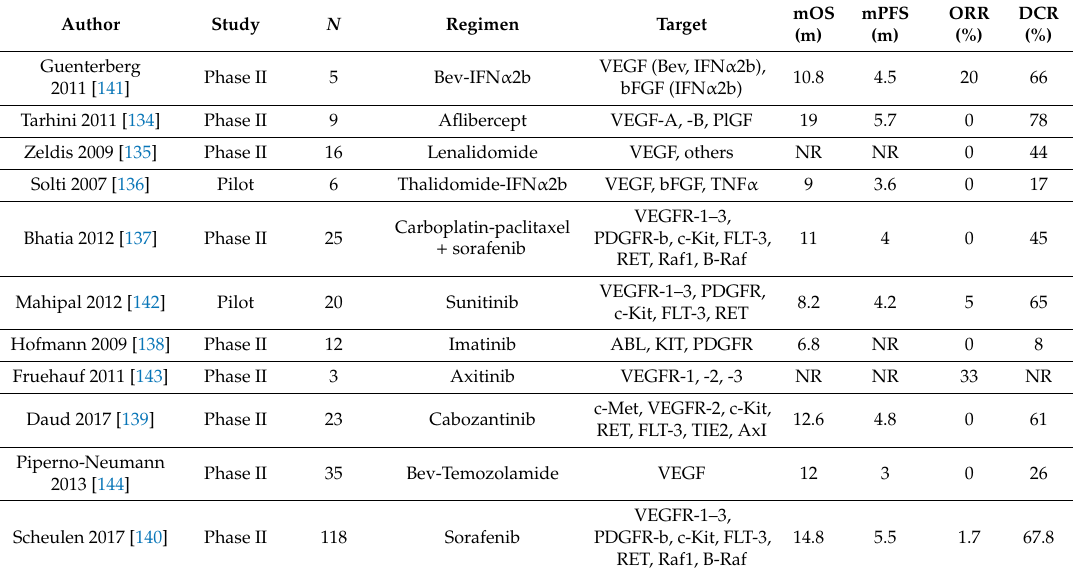
Table 1. Selected clinical trials with antiangiogenic drugs in metastatic uveal